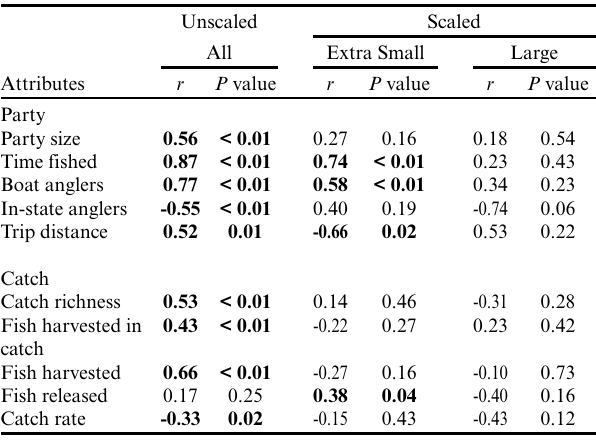
Table 3 . Pearson correlation analysis (r and P values) relating water body size for unscaled data (all water bodies) and scaled data (extra small and large water body groups) to party (top) and catch (bottom) attributes of a regional recreational fishery in Nebraska. Party attributes include party size, time fished, boat anglers, in-state anglers, and trip distance. Catch attributes include catch richness, fish harvested in catch, fish harvested, fish released, and catch rate. Significant relationships are indicated with bold font.